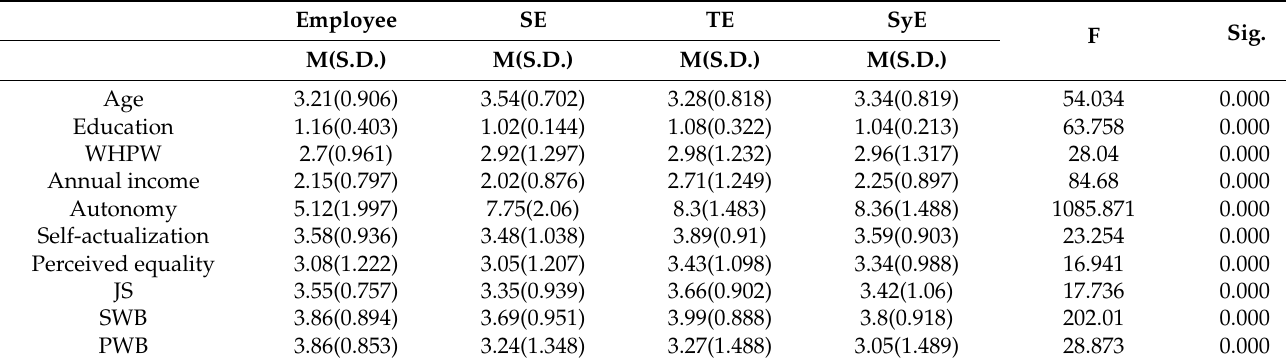
Table 9. Comparison between the employees and 3 categories of